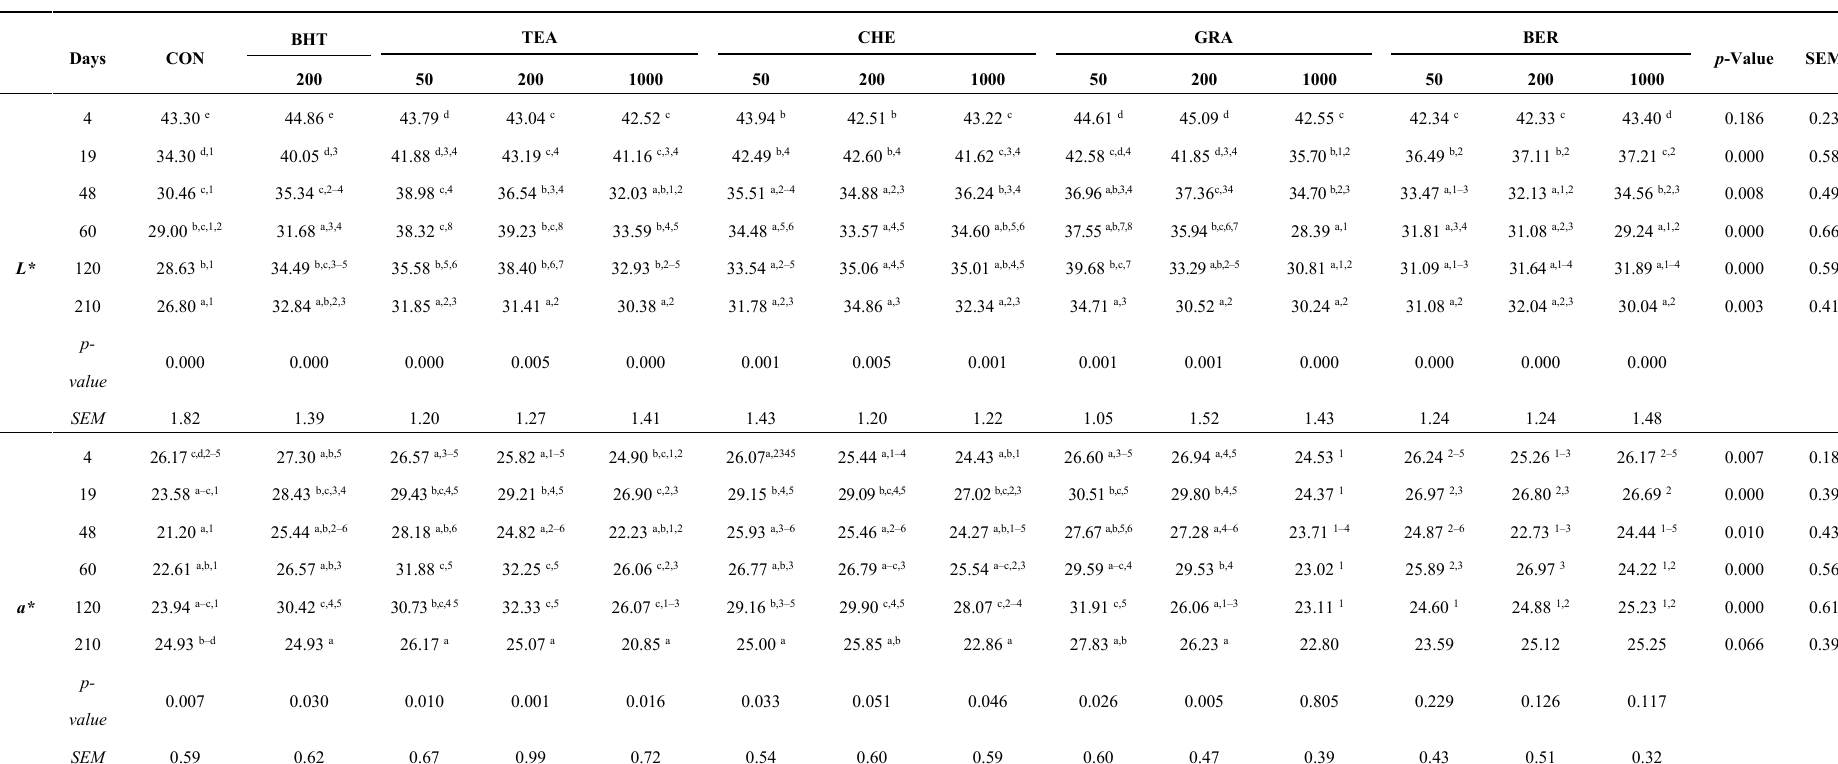
Table 1. Evolution of color parameters of “chorizo” treated with BHT and natural antioxidants during ripening and